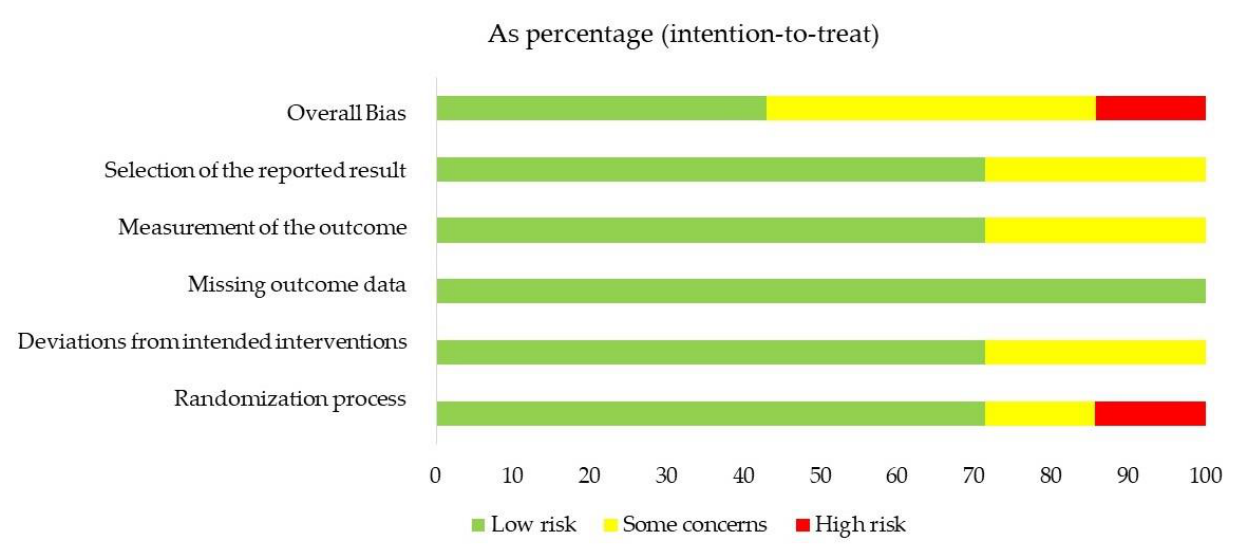
Figure 2. Risk of bias assessment graph of the included studies.